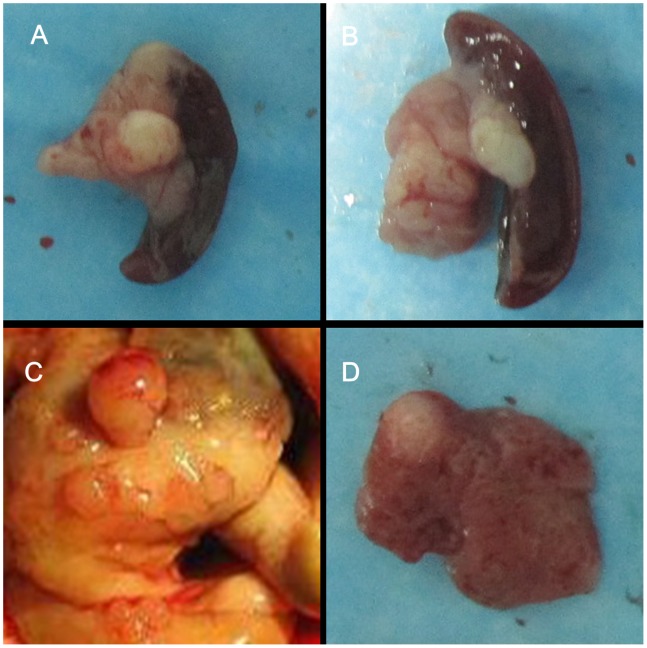
Pancreatic tumor formation and metastasis in the DMBA-induced PC rat model.(A) Pancreatic tumor of 1-month group. (B) Pancreatic tumor of 3-month group. (C) Small intestine metastasis nodules of pancreatic tumor. (D) Liver metastasis nodules of pancreatic tumor.